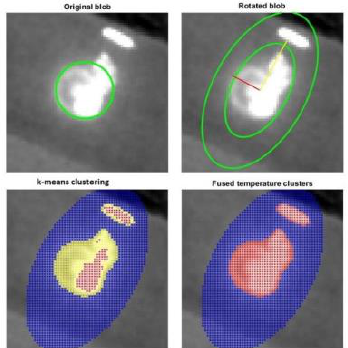
Figure 3 Anomaly detection with cluster merging